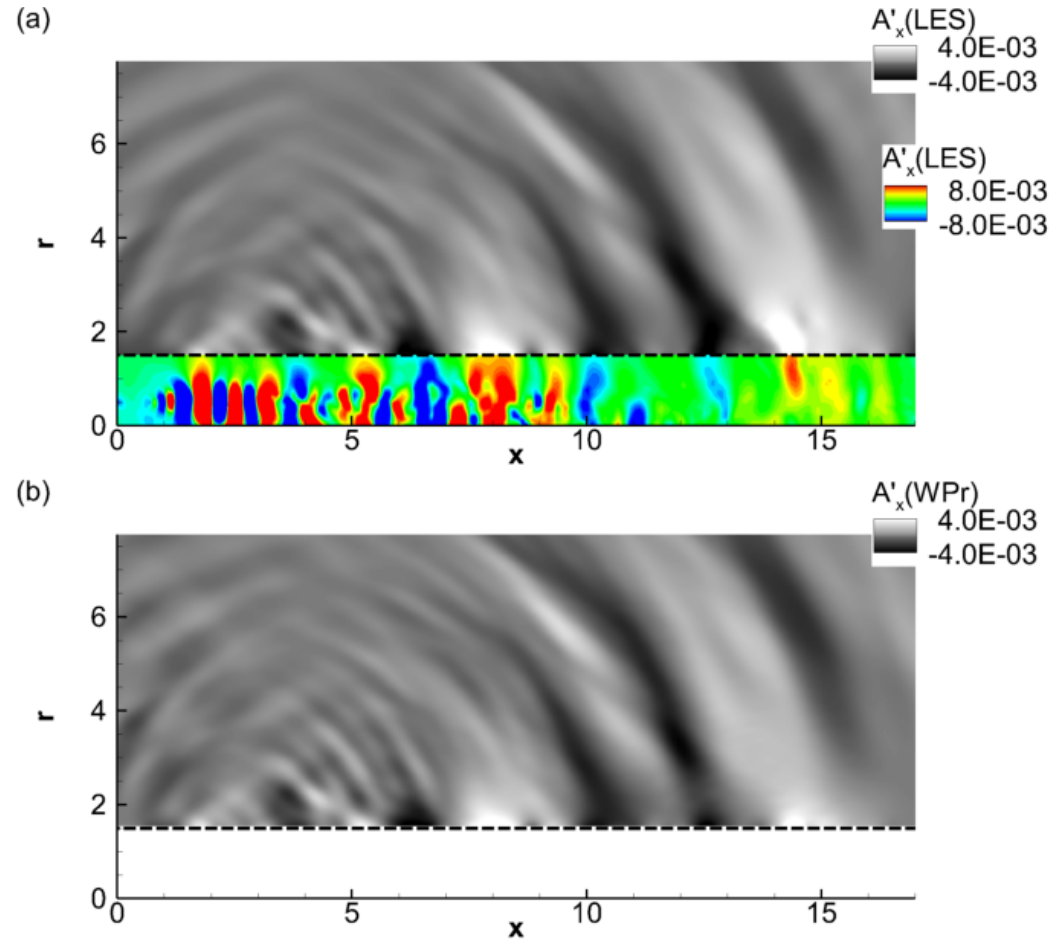
Figure 11. ( a ) An instantaneous acoustic field, A (cid:48) x , extracted from the LES; ( b ) The predicted A (cid:48) x field at the corresponding time-instant, using a homogeneous wave propagator. The wave propagator is forced at r = 1.5 (marked using a horizontal dotted line). The color and gray-scale contours in ( a ) simply demarcate the zone of prediction in the wave propagator solution for easy comparison. The jet-flow direction is from left to